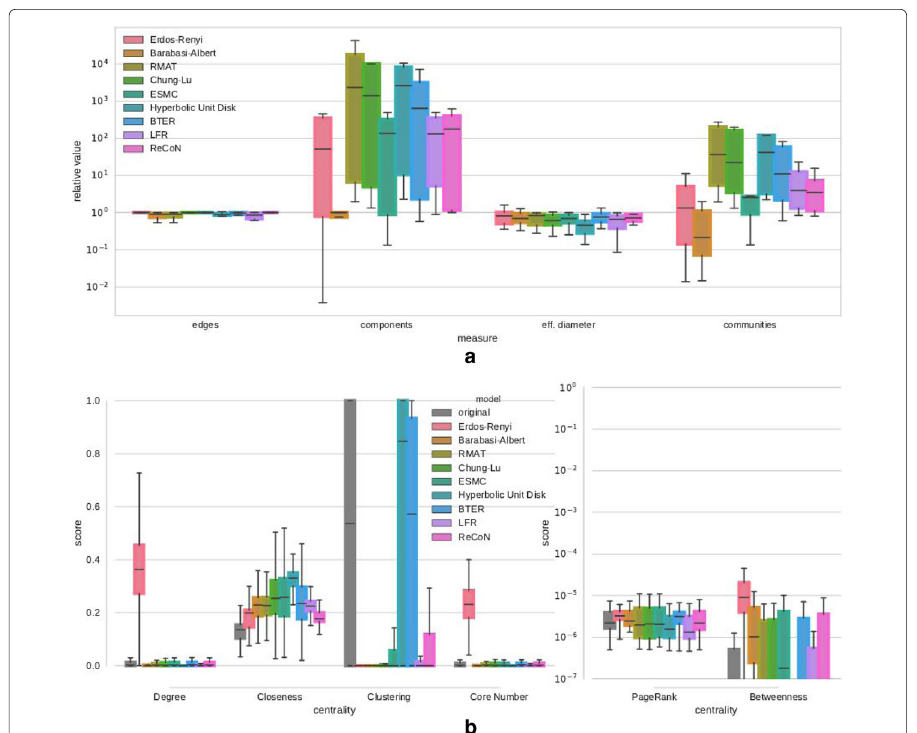
Fig. 10 Structure replication of diverse set of networks (Table 2). a Relative deviation of scalar network properties, b Distribution of centrality